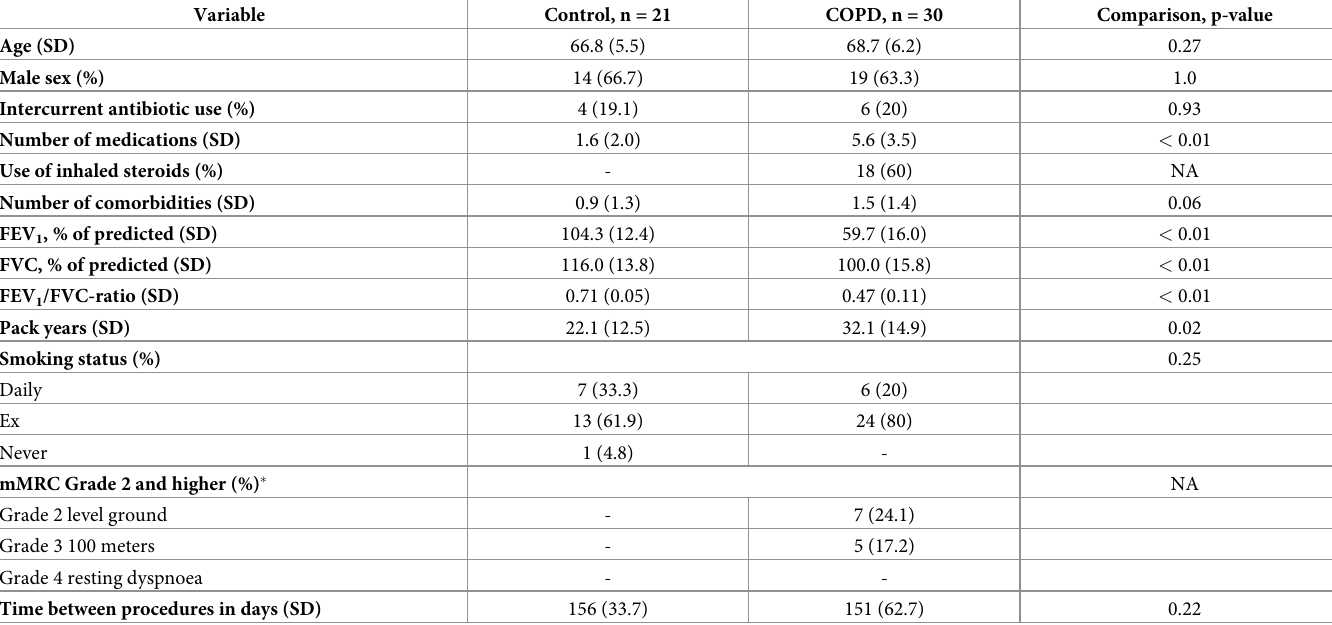
Table 1. Demographics of participants included in fungal longitudinal analyses in the MicroCOPD